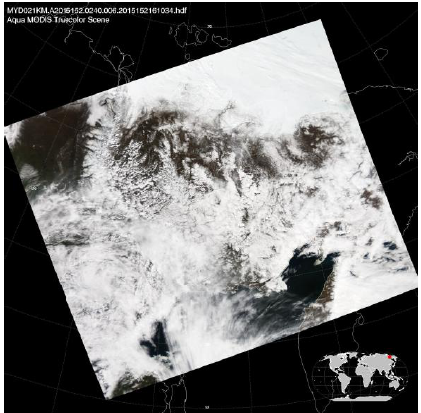
Figure 2. Moderate Resolution Imaging Spectroradiometer (MODIS) RGB (Red, Green, and Blue) scene from 02:40 to 02:45, on 1 June 2015 [42].